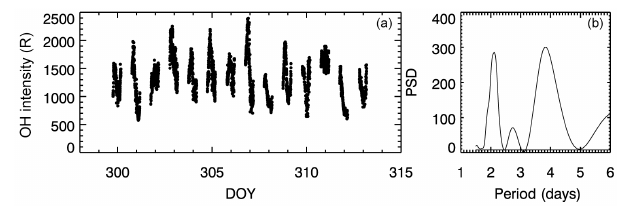
Figure 1. Example of the nightly OH airglow intensity between 26 October and 8 November 2005 (a) and its corresponding Lomb– Scargle periodogram (b)